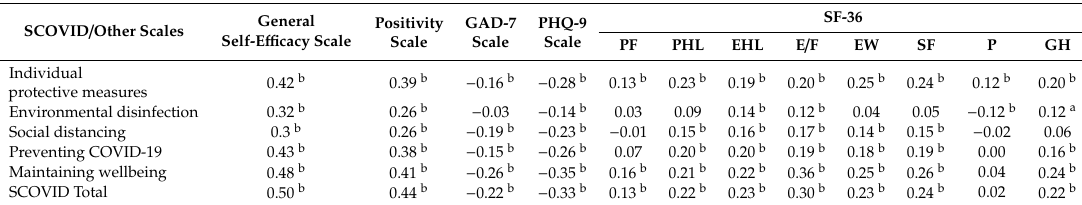
Table 3. Pearson’s correlations between the SCOVID scale and other scales (construct validity) ( N = 461). SCOVID / Other Scales Individual protective measures